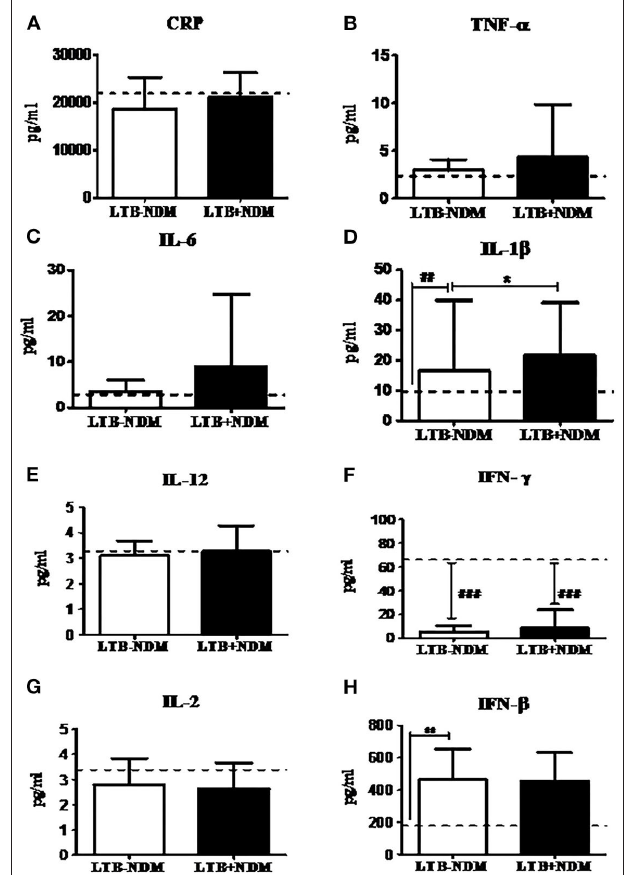
FIGURE 5 | LTBI increases IL-1 β levels in NDM subjects. The circulating levels of pro- inflammatory cytokines, Th1 cytokines, and type-1 interferon in NDM subjects were quantified by ELISA. Bar graph showing the circulating levels of CRP (A) , TNF- α (B) , IL-6 (C) , IL-1 β (D) , IL-12 (E) , IFN- γ (F) , IL-2 (G) , and IFN- β (H) in the serum of LTB-NDM ( n = 39) and LTB + NDM ( n = 39) subjects. The basal level, as was seen in LTB-NGT, is shown as dashed line (—-), as reference. Statistical significance was determined by non-parametric Mann–Whitney U test and p < 0.05 was considered significant. * p < 0.05; **